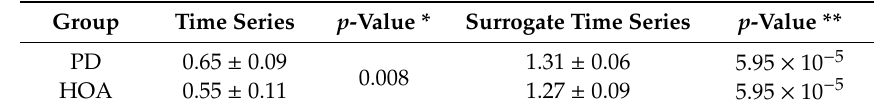
Table 3. Sample entropy of original and surrogate time series for people with Parkinson’s disease and healthy older